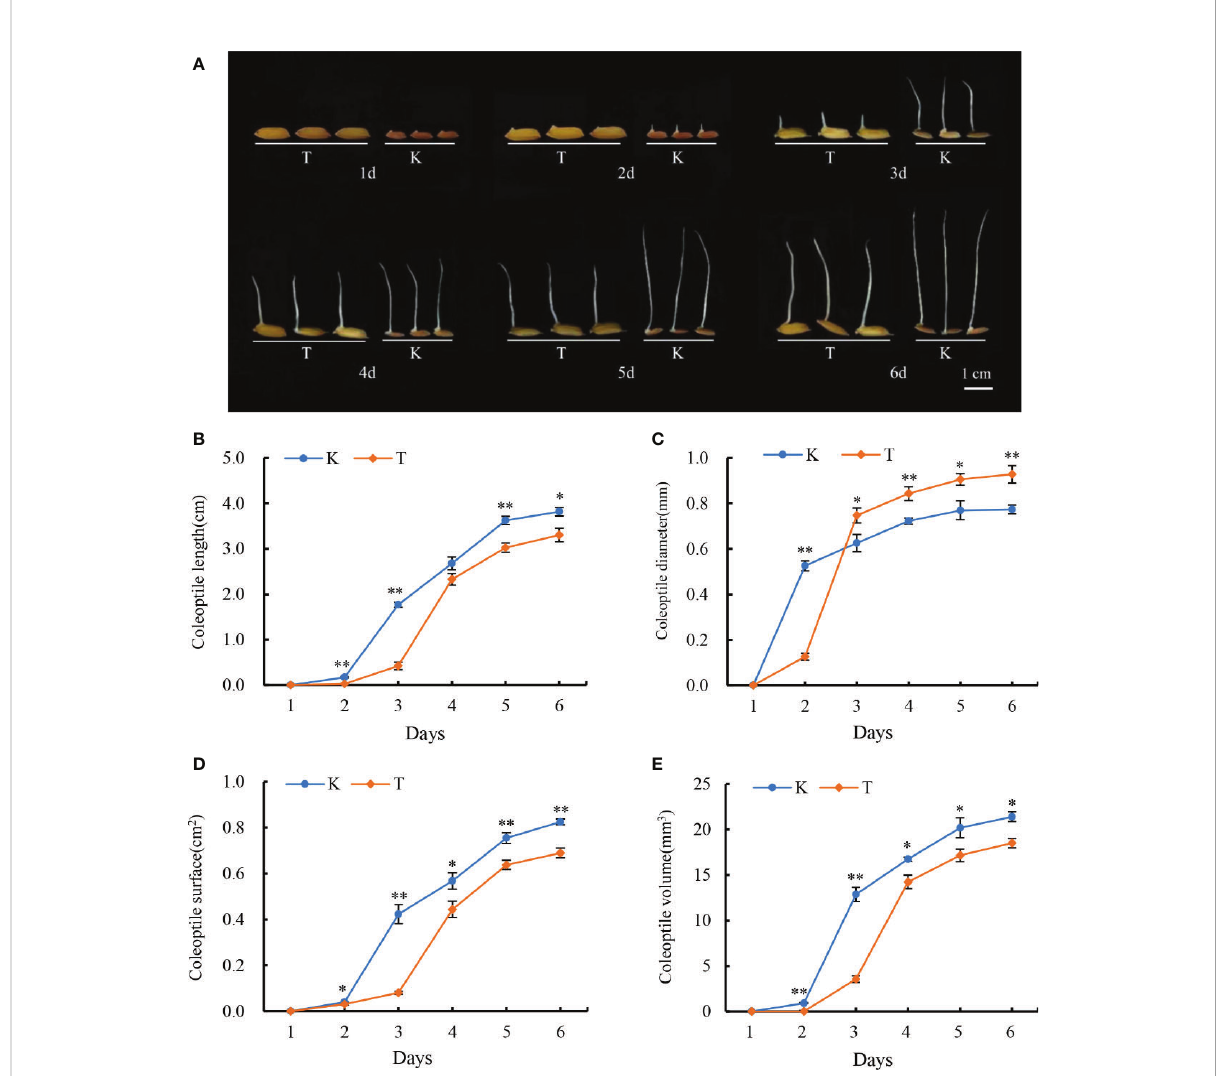
FIGURE 1 Dynamic of TD70 and Kasalath coleoptile developments under anaerobic conditions (A) . The phenotypes of two parents 1-6 days under anaerobic conditions; (B – E) represent the change of coleoptile length, diameter, surface area, and volume 1-6d under anaerobic conditions, respectively. K, Kasalath; T, TD70; * and ** represent the signi fi cant p <0.05 and p < 0.01,